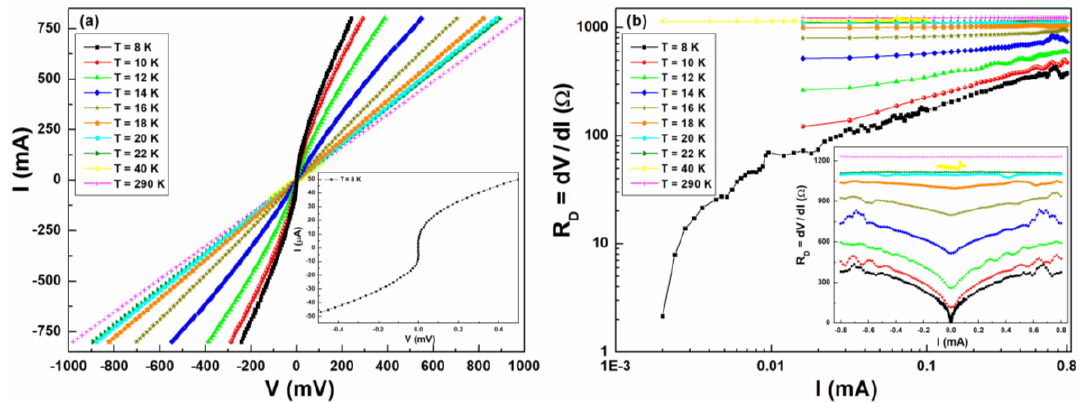
Figure 4. Current–voltage ( I–V ) characteristics. ( a ) The di ff erent curves refer to temperatures from 8 to 290 K. An enlargement of the I–V curve at the temperature of 8 K is shown in the inset. ( b ) The DC current dependence of the di ff erential resistance R D is reported at di ff erent temperatures in the log-scale. In the inset, the full current range, spanning from negative to positive values, is shown using a